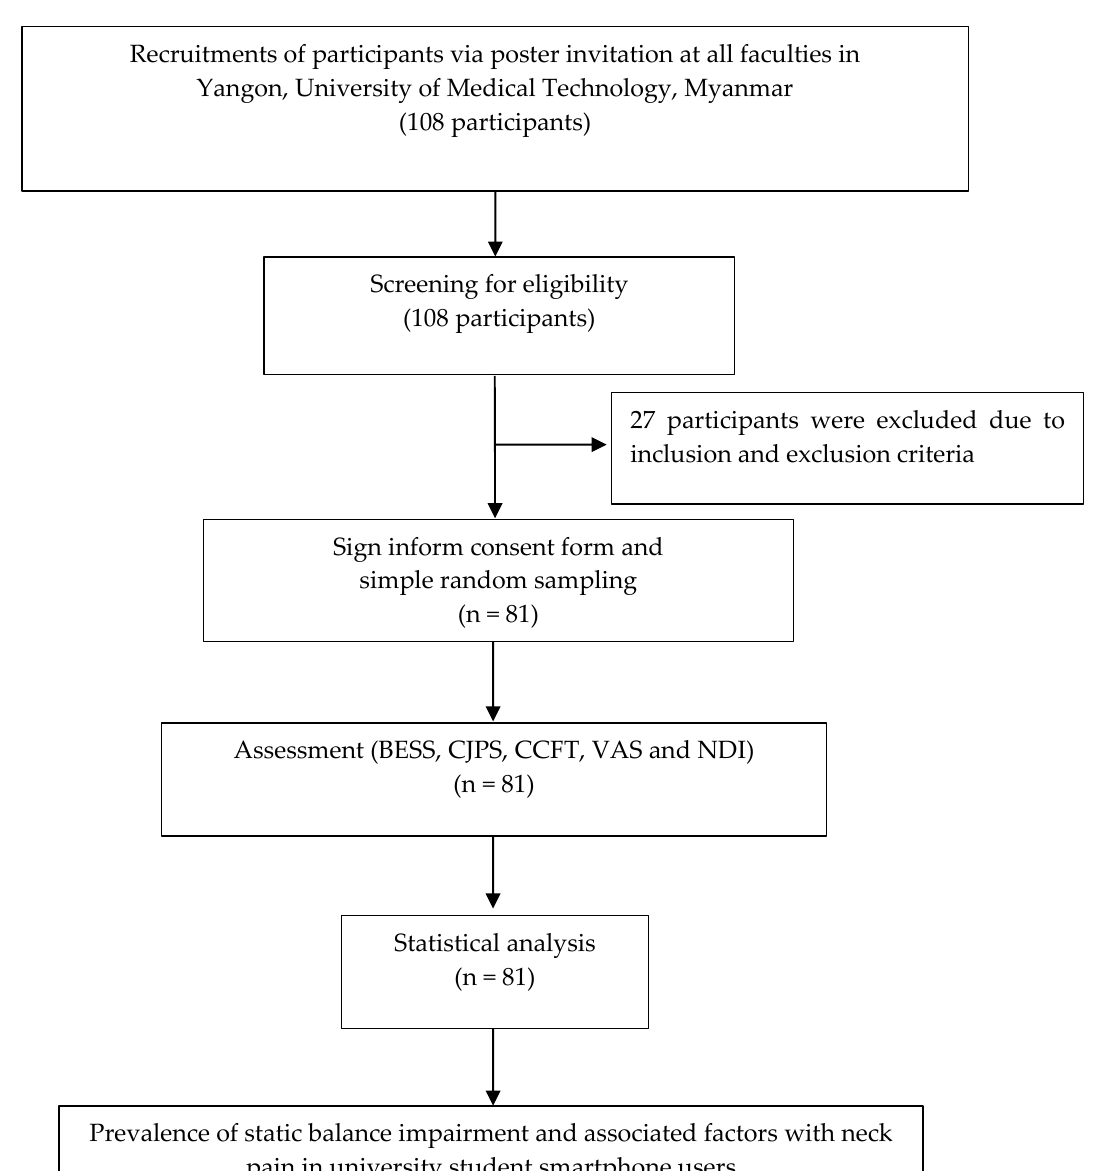
Figure 1. A flow diagram of participation in the study.